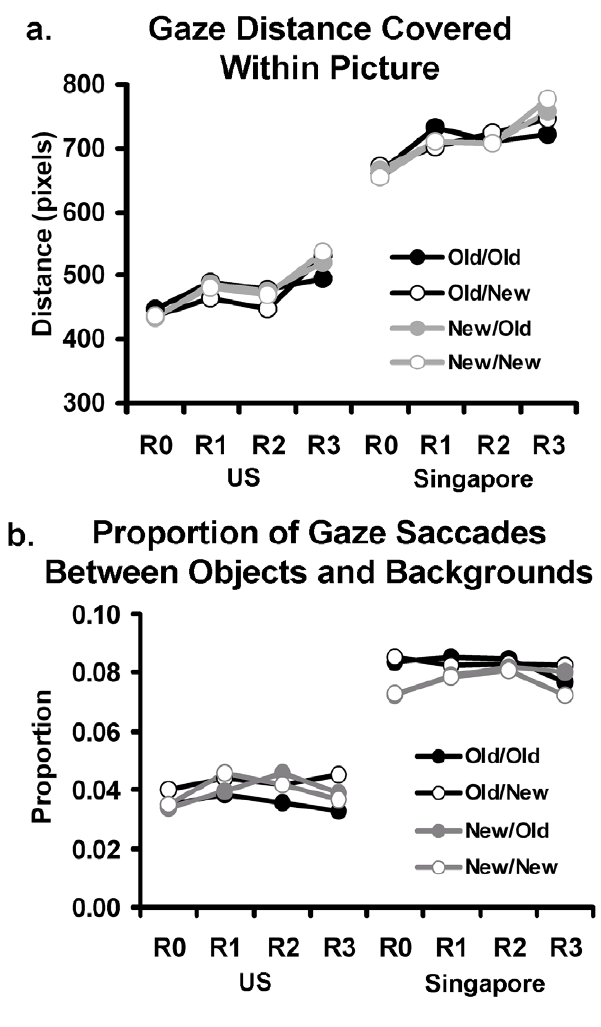
Figure 4. Eye gaze data for US and Singapore participants. Mean gaze distance covered within pictures (a) and proportion of gaze saccades between objects and backgrounds (b) are shown across all quartet conditions and picture